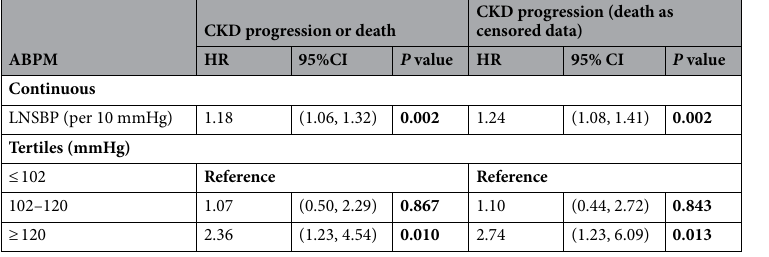
Table 3. Hazard ratio (HRs) (95% CI) for clinical outcomes (ESRD, 40% eGFR decline or death) per 10 mmHg increase in LNSBP in elderly CKD patients. Model adjusted for age, gender, smoking status, medical history of hypertension and diabetes, estimated GFR, 24 h proteinuria, etiology of CKD. LNSBP the lowest nocturnal systolic blood